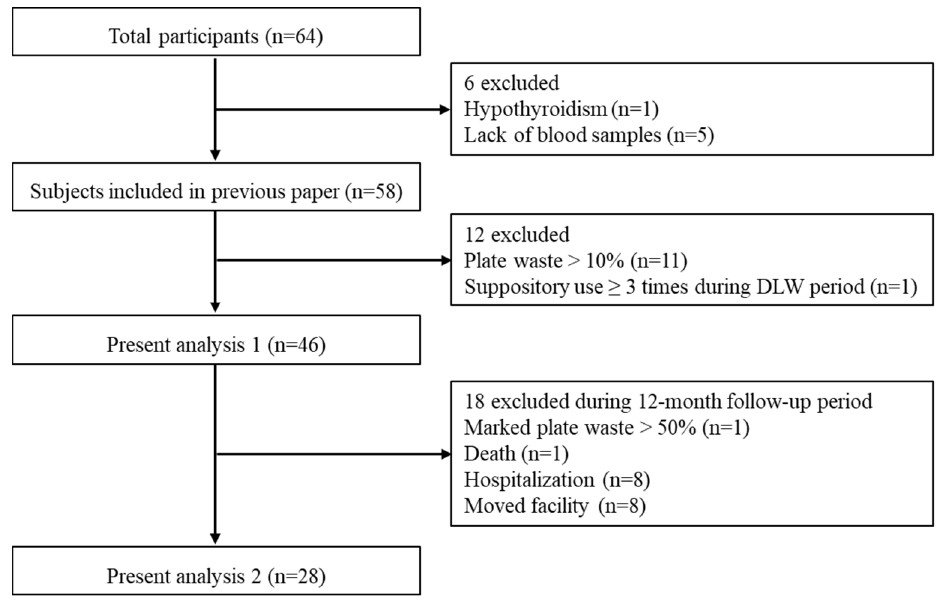
Figure 1. Flowchart of the exclusion criteria for the study.